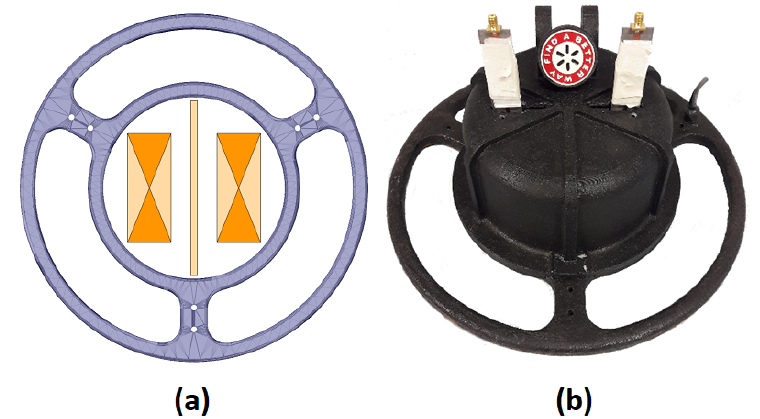
Figure 7. ( a ) The location of GPR antennas within the MIS sensor head; and ( b ) photograph of the combined sensor head.